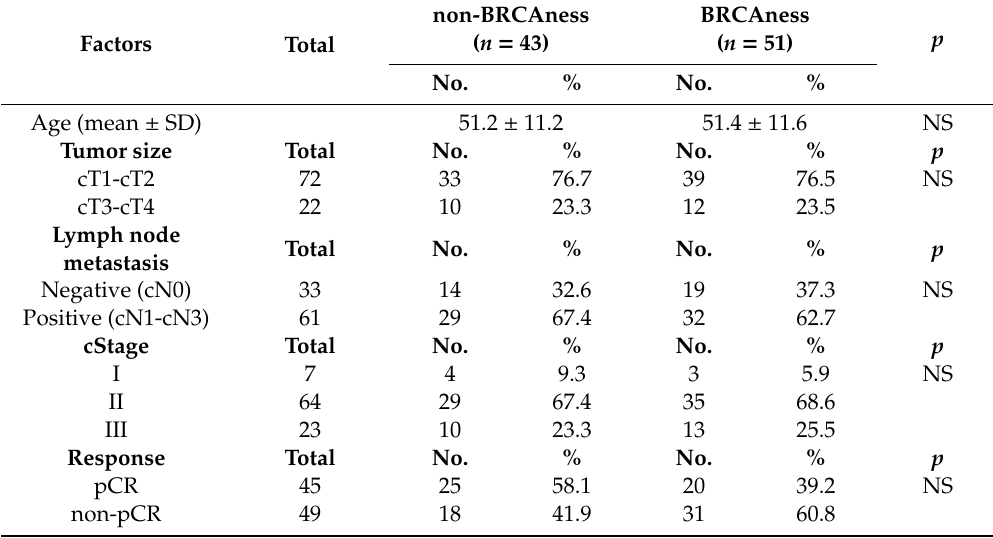
Table 2. Correlation of clinicopathologic characteristics and BRCAness of biopsy.